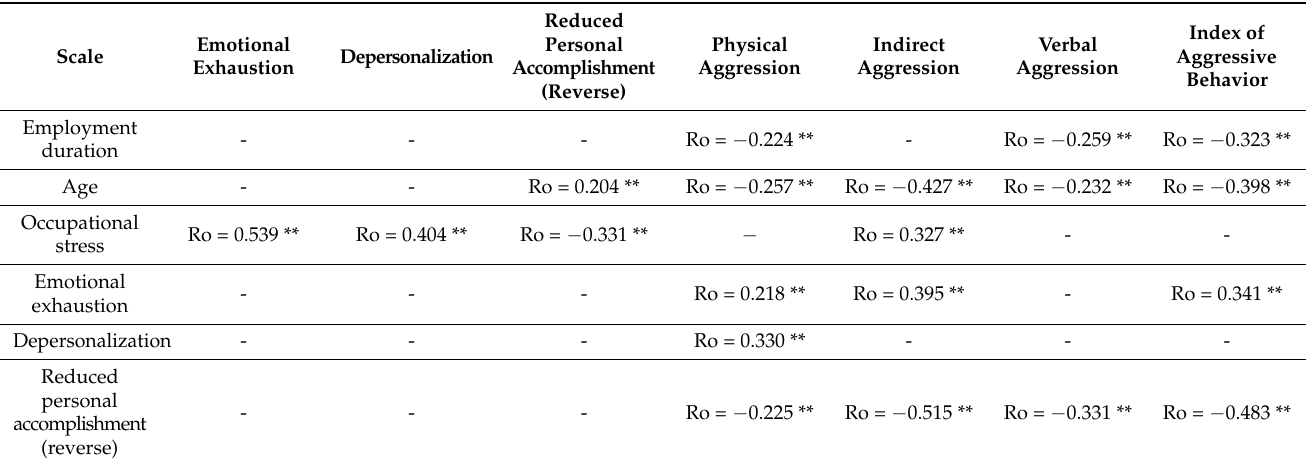
Table 6. Correlation analysis (Ro–Spearman) of occupational burnout, aggressive behavior, occupa- tional stress, and age and employment duration in COVID-19 ICU